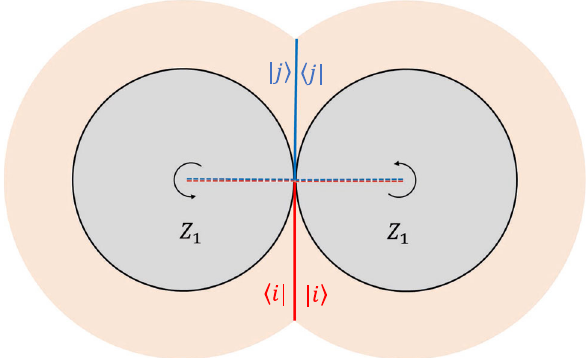
at the late stage of evaporation. We can add all the different saddles together, and the transitions between different sad- dles lead to an entropy of radiation that is consistent with the unitarity